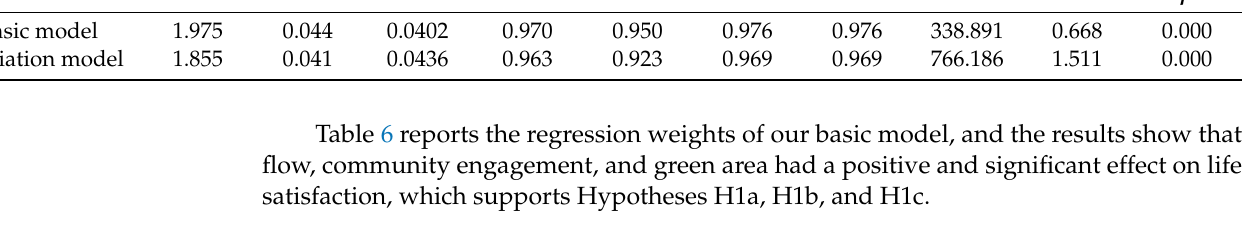
Table 6. Regression coefficients of the basic model.